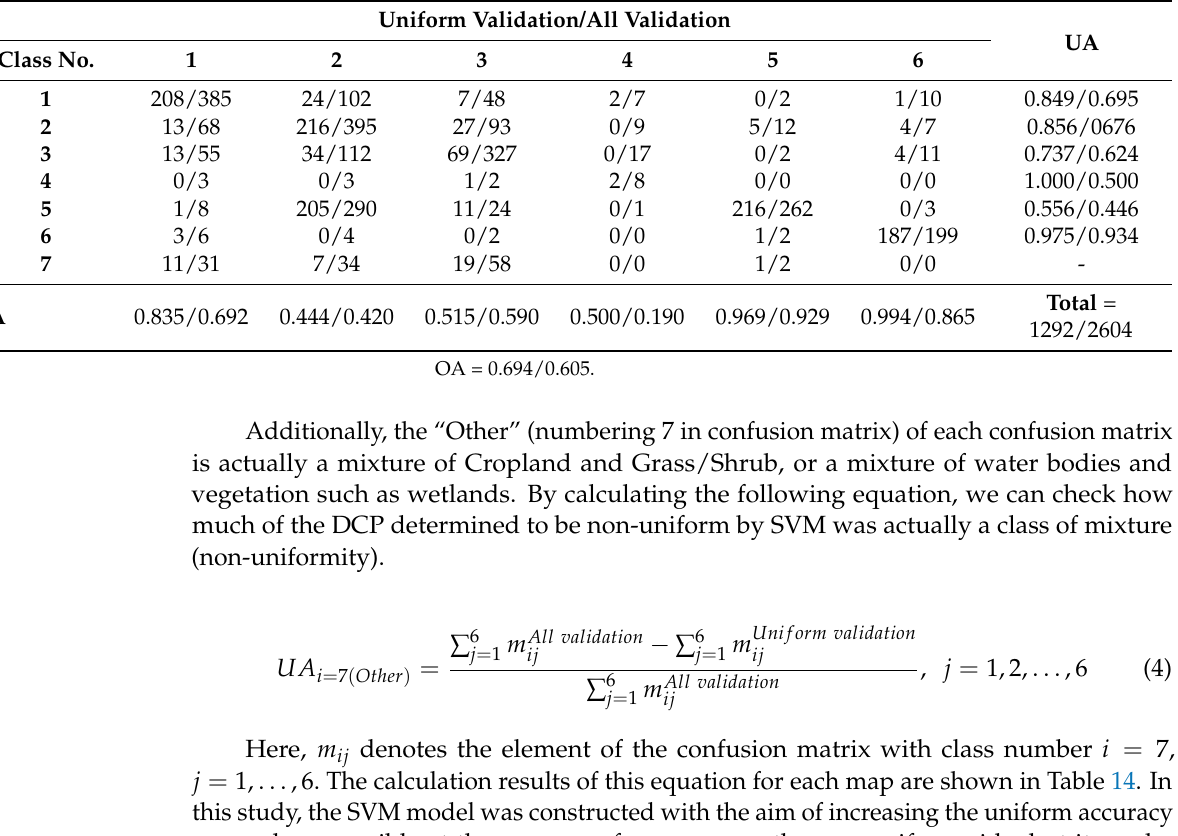
Table 13. Confusion matrix for GLC2000 in 990 m scale.